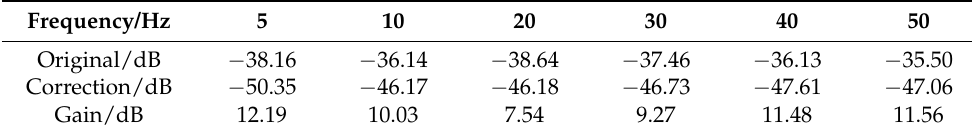
Table 1. Results of PSD for original and correction at different frequencies.